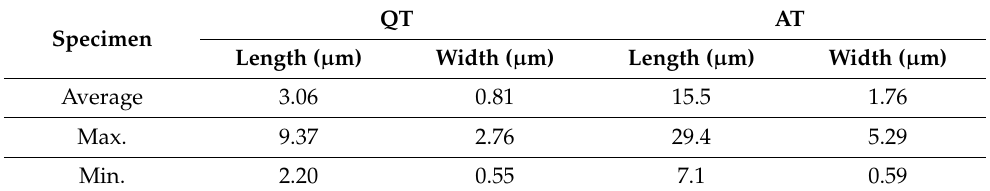
Table 1. Comparison of the average length and width of the laths between QT and AT specimens.